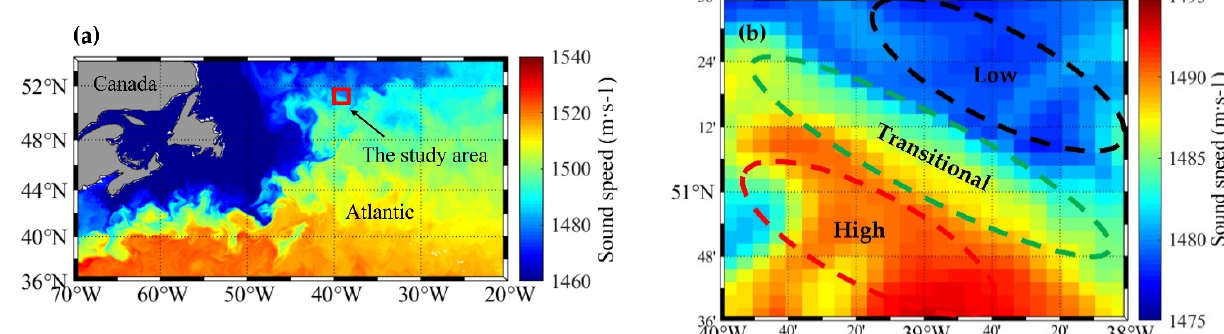
Figure 1. ( a ) The surface sound speed of parts of the North Atlantic and the location of the study area (the scope of the study area is 38°–40° W, 50.6°–51.6° N); ( b ) The sea surface sound speed distribution of the study area on 1 January 2019. Due to the existence of the GSF, the study area is divided into three water masses with different properties. They are high sound speed (high temperature and salinity) water mass, which is located in the southern part of the frontal zone; low sound speed (low temperature and salinity) water mass, which is located in the northern part of the frontal zone; transitional water mass, which is located in the frontal zone.